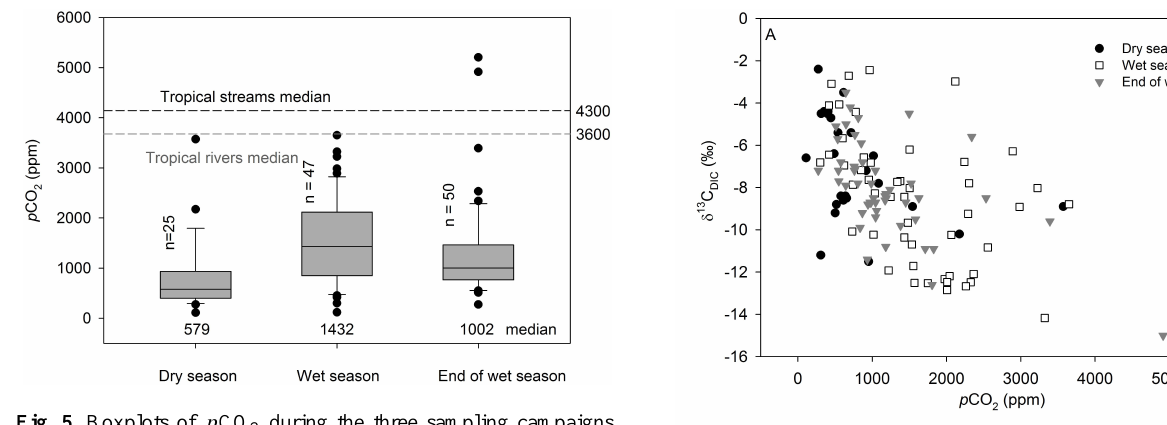
Fig. 5. Boxplots of p CO 2 during the three sampling campaigns. The centre line, box extent, error bars, and dots denote the 50th percentile, 25th and 75th percentiles, 10th and 90th percentiles, and outliers of estimates, respectively. Horizontal dashed lines represent tropical medians for rivers and streams (Aufdenkampe et al., 2011).